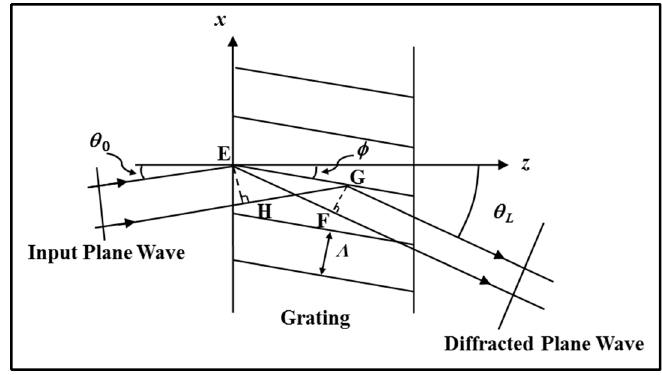
Figure 7. Schematic of a volume transmission grating, following [19].